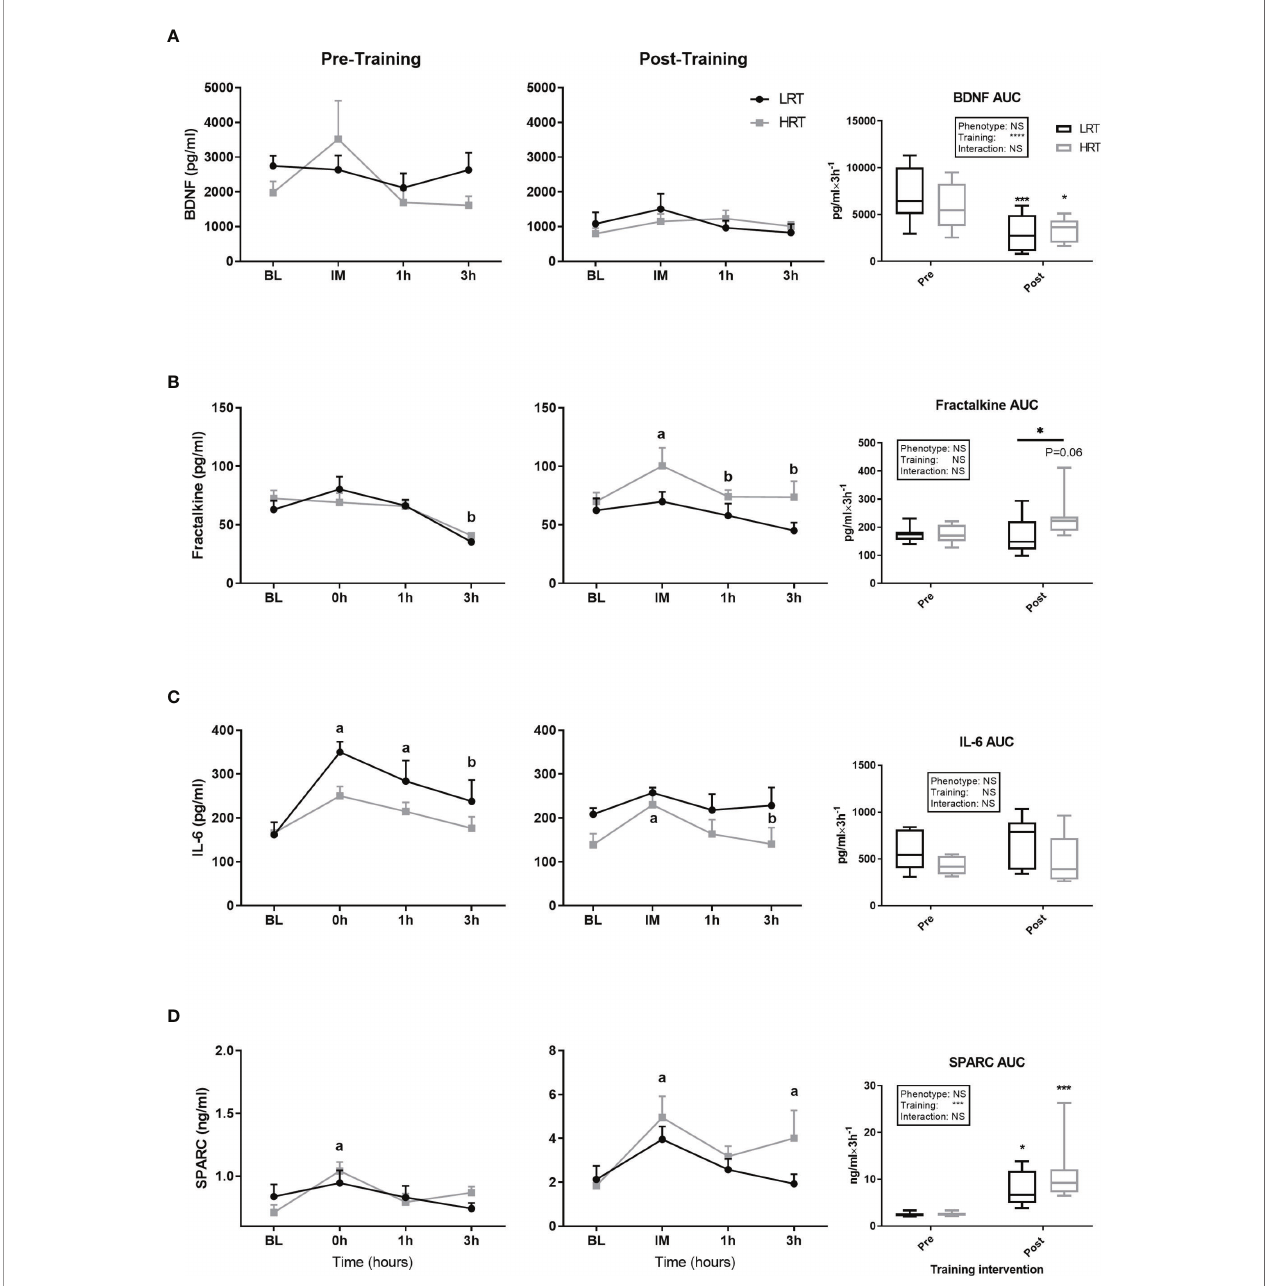
FIGURE 4 | Temporal change in concentration of plasma myokines and area under the curve (AUC) before and after exercise training. (A) Brain-derived neutrophic factor (BDNF); (B) Fractalkine; (C) Interlukin-6 (IL-6); (D) Secreted protein acidic and rich in cysteine (SPARC); Baseline (BL). Values are means±SD. Analysis via two-way ANOVA with Sidak ’ s post hoc test. Main effects are shown in the text box. *P<0.05, ***P<0.001, NS, Not Signi fi cant. a=signi fi cant change from BL. b= signi fi cant change from 0h. Non-underlined symbols represent within group differences. Underlined symbols represent between groups